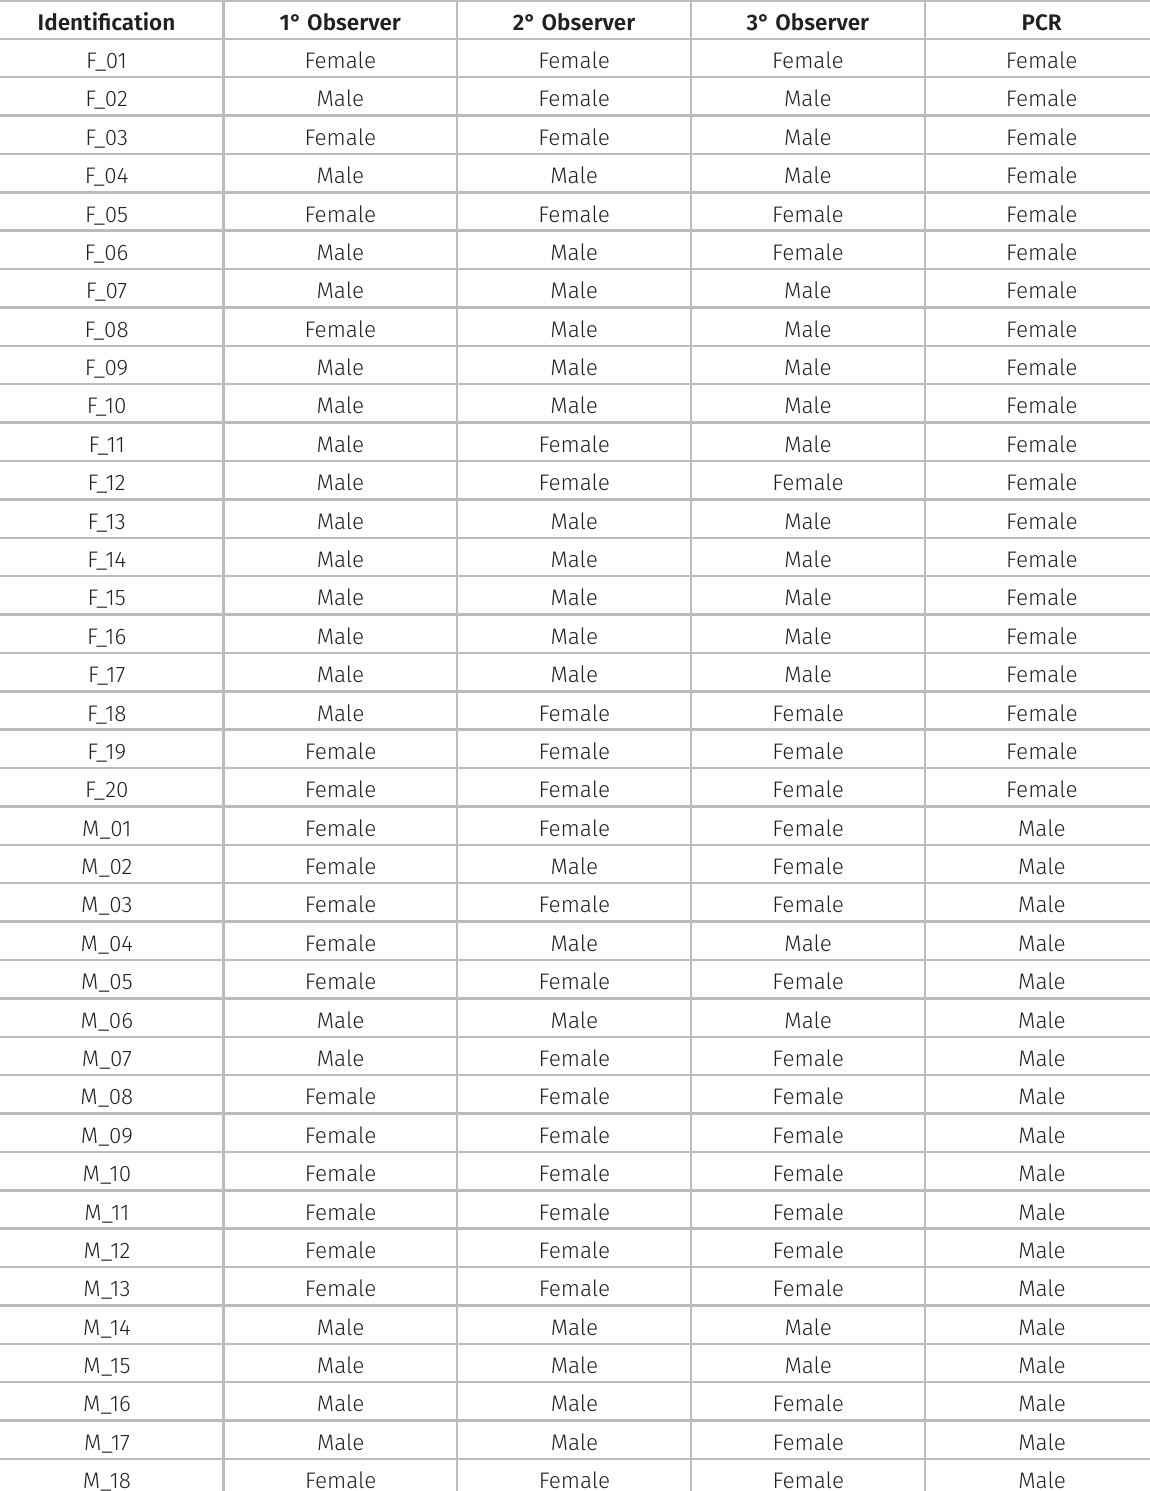
Table I. Observer’s suggestions based on iris dichromatism compared to molecular sexing by PCR.